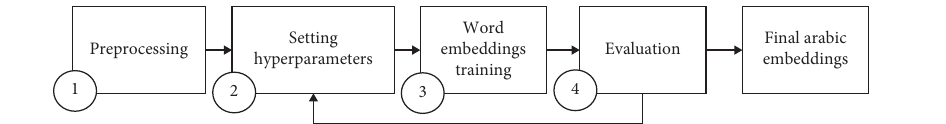
Figure 1: Steps for generating the final embeddings. (1) Preprocessing. (2) Setting hyperparameters. (3) Word embeddings’ training. (4) Evaluation to choose the best embeddings that will be used in the synonyms extraction process.